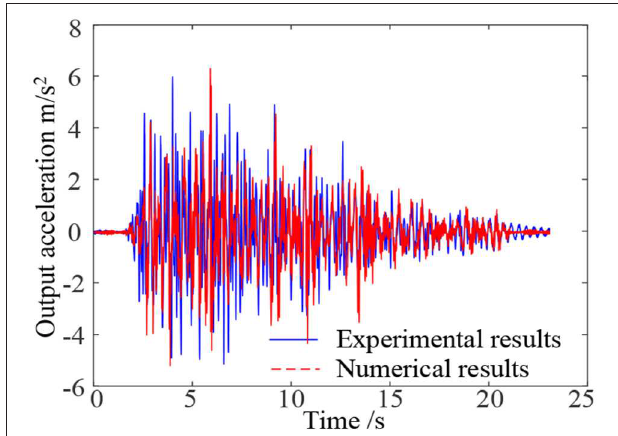
FIGURE 9 | Acceleration responses.